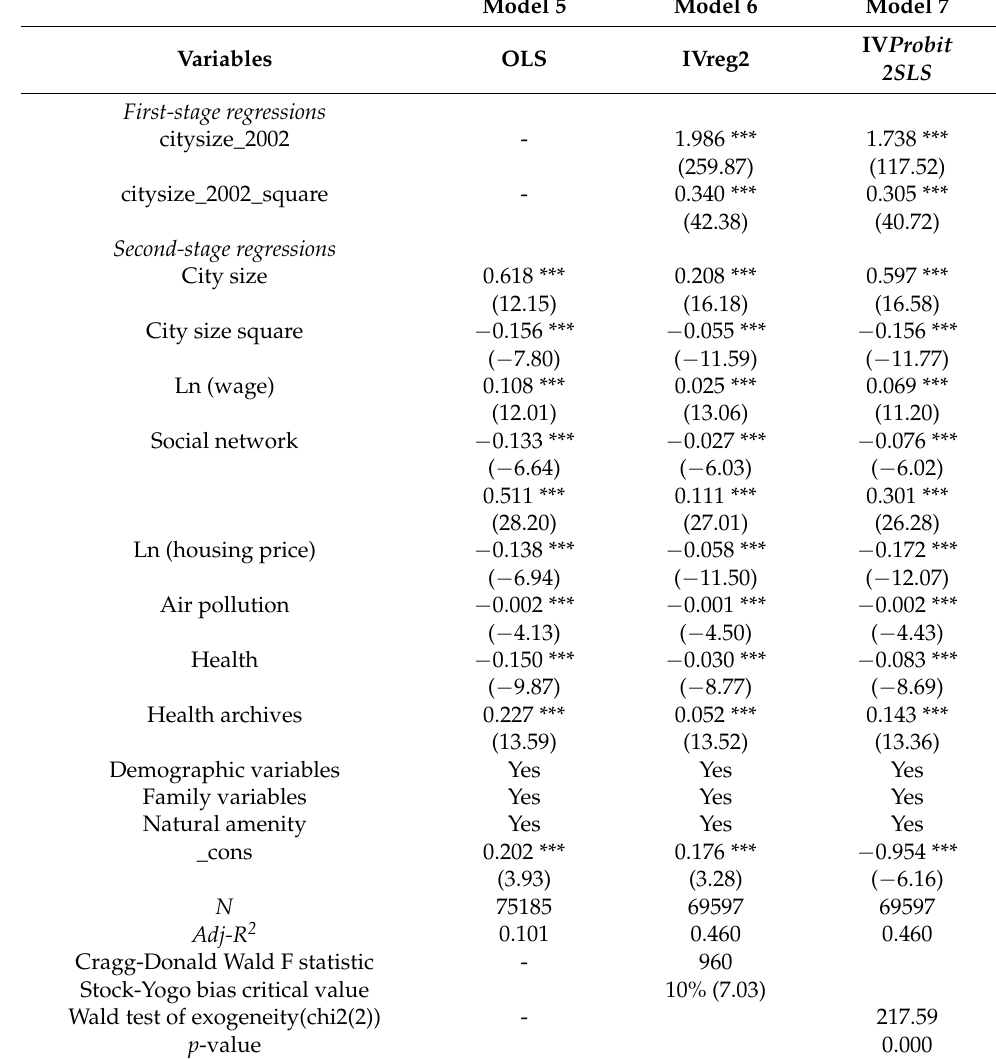
Table 4. The results of IV estimation of